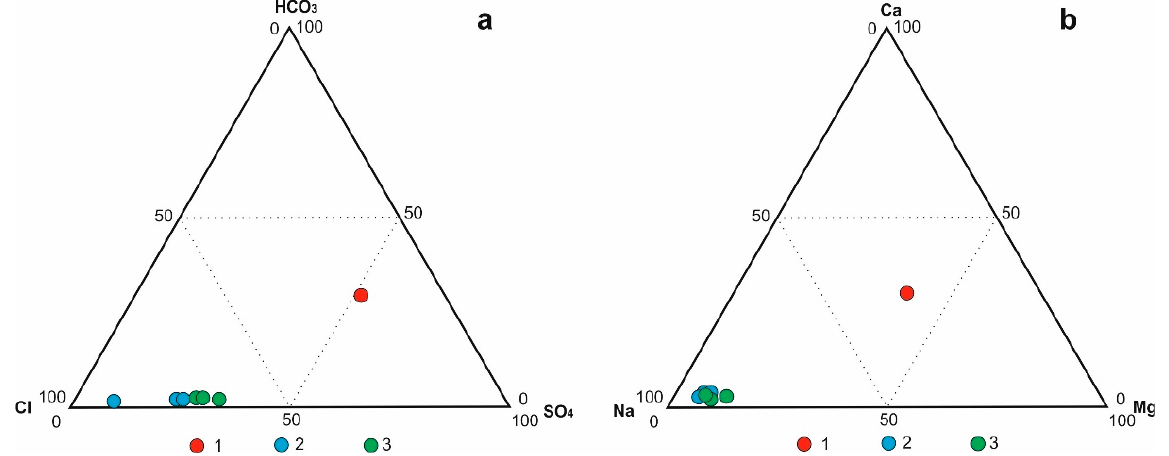
Figure 5. Ferre triangles with data on the chemical composition of different types of Lake Taloe waters: groundwater (1), surface water (2), pore water of lake sediments (3). ( a ): anions; ( b ): cations.